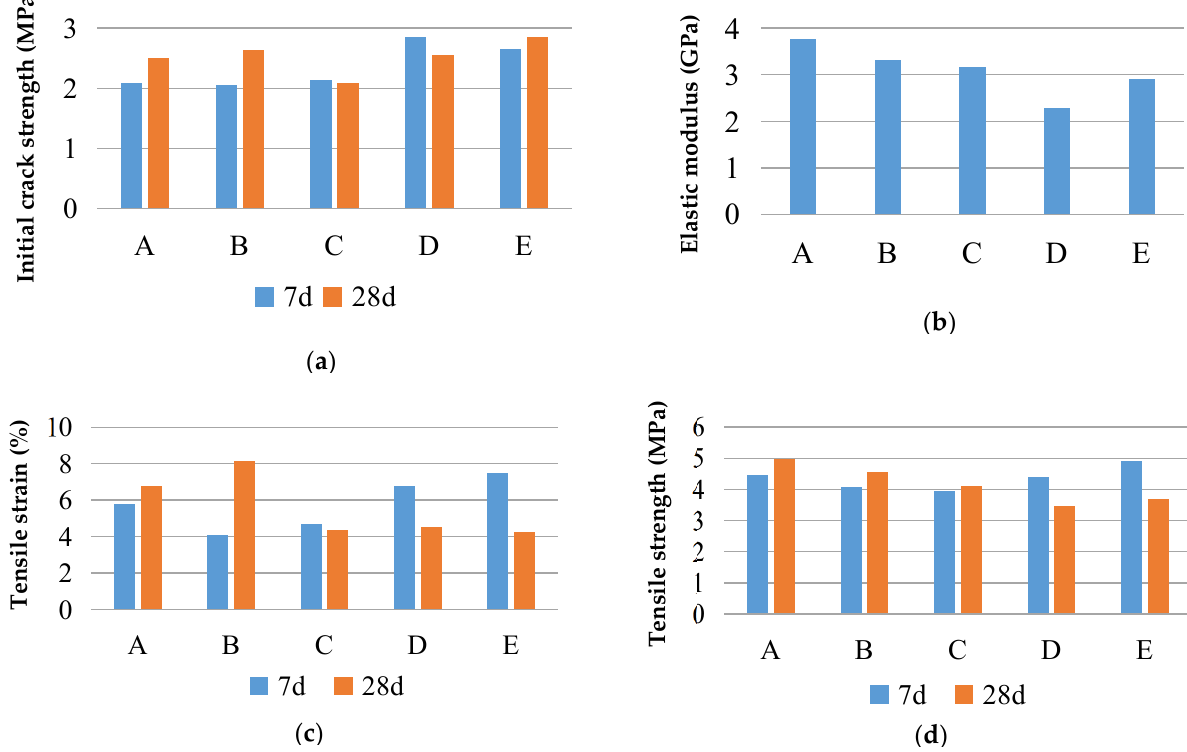
Figure 12. Uniaxial tensile properties of specimens with different particle sizes and ages: ( a ) initial crack strength; ( b ) elastic modulus; ( c ) tensile strain; ( d ) tensile strength. According to the 28-day tensile elastic modulus, for Groups A and B, the tensile elastic moduli are 3.76 GPa and 3.31 GPa, respectively. The tensile elastic modulus of the ECCs with desert sand is higher, but the difference is not significant. For ordinary sand, the tensile elastic modulus of Group B with fine particles is higher than the tensile elastic modulus of Groups C–E. The tensile elastic modulus decreases as the particle size in- creases.